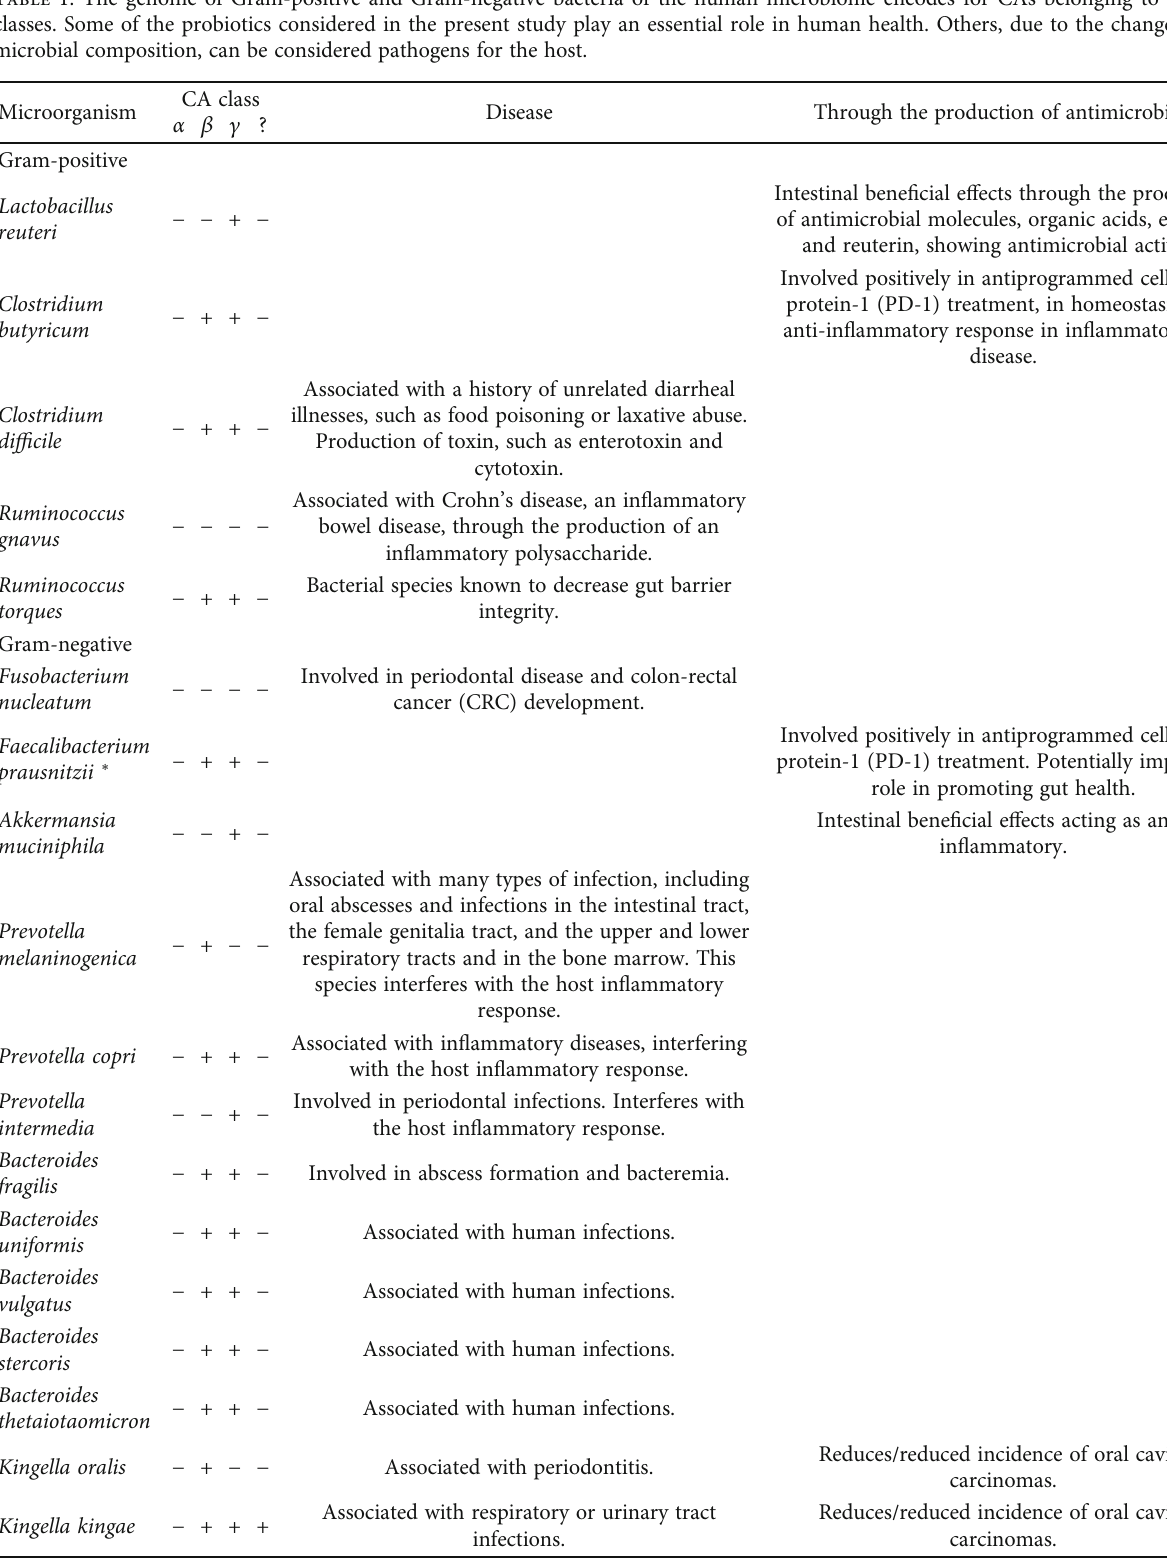
Table 1: The genome of Gram-positive and Gram-negative bacteria of the human microbiome encodes for CAs belonging to di ff erent classes. Some of the probiotics considered in the present study play an essential role in human health. Others, due to the changes in the microbial composition, can be considered pathogens for the